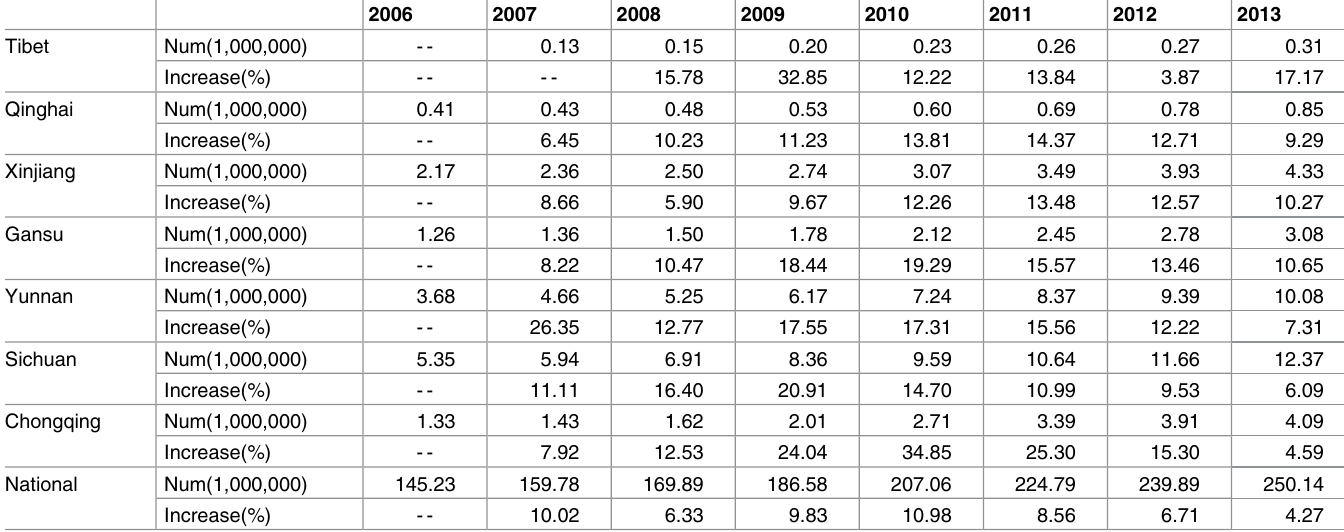
Table 3. Number of registered vehicles from 2006 to 2013 in high-altitude provinces and nationally in China.